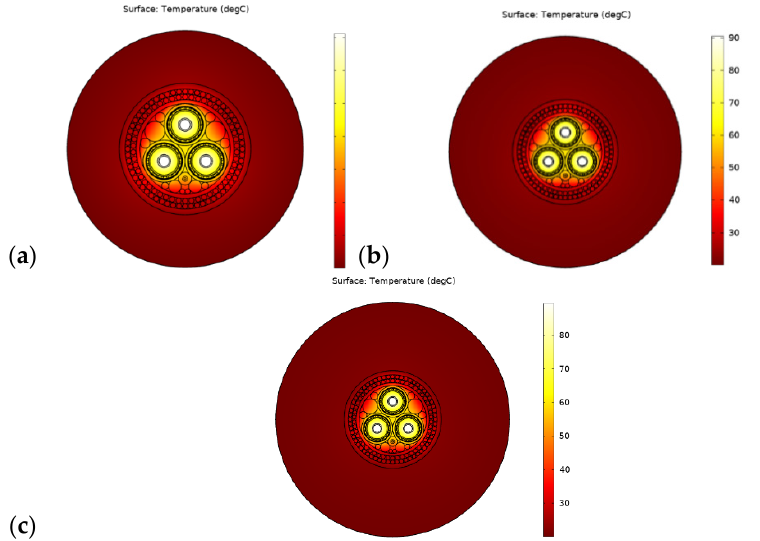
Figure 15. Steady-state temperature ( ◦ C) distribution for different ages of mussels ( a ) Juvenile, ( b ) Mix ( c ) Adult.